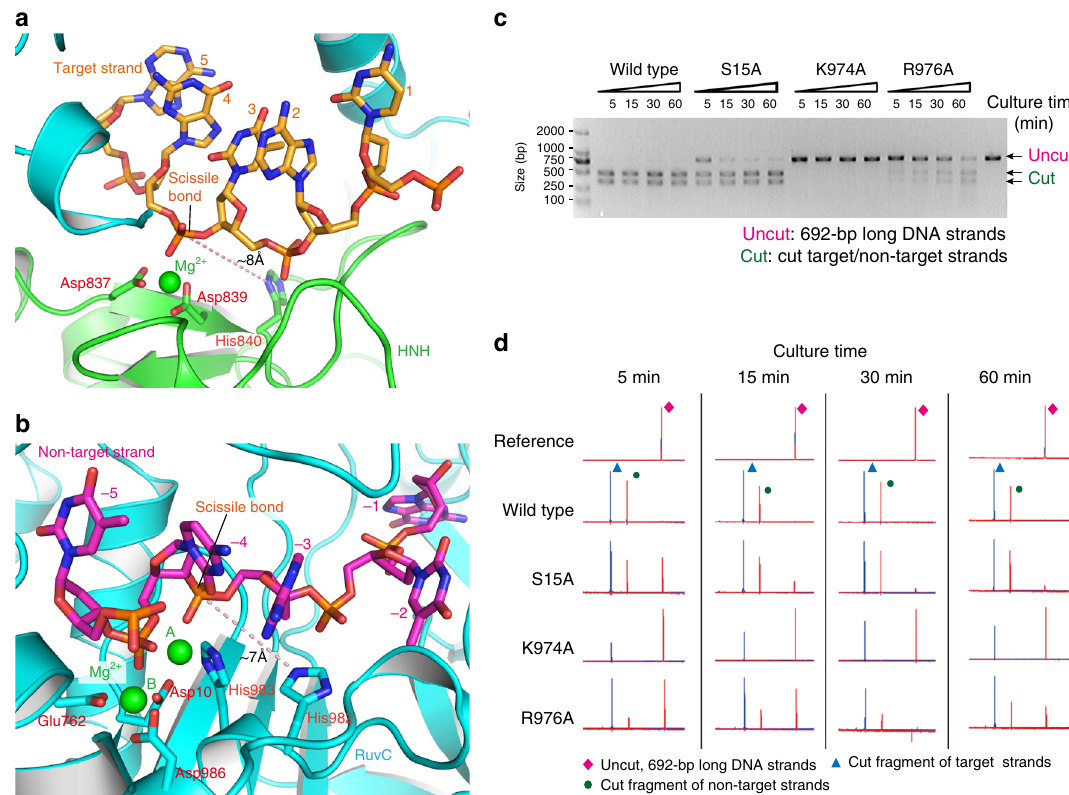
Fig. 5 The MD models of the wild-type HNH and RuvC active sites. a Close-up view of the HNH active site in complex with the target strand and one Mg 2+ ion. b Close-up view of the RuvC active site in complex with the non-target strand and two Mg 2+ ions. c DNA cleavage activities of the wild-type SpCas9 and three mutants detected by agarose gel electrophoresis. d DNA cleavage activities detected by capillary electrophoresis. The reference is the uncut, 692-bp long DNA strands. Data are shown for one representative experiment from three independent experiments with similar